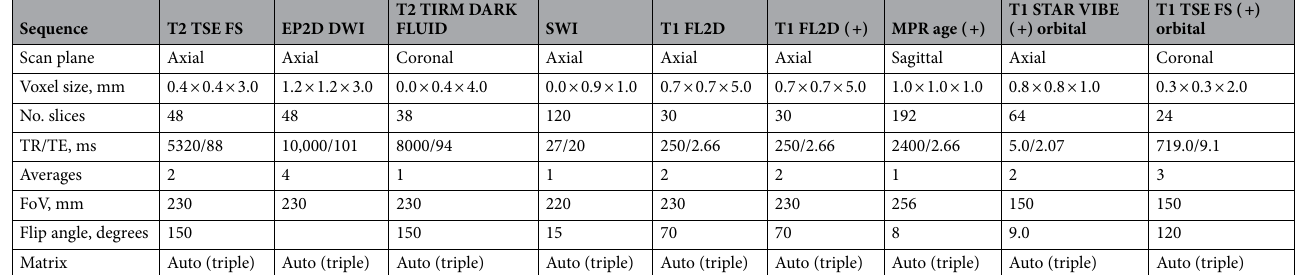
Table 1. Parameters of the imaging protocol of the brain and the optical nerves. All sequences without contrast medium except marked with